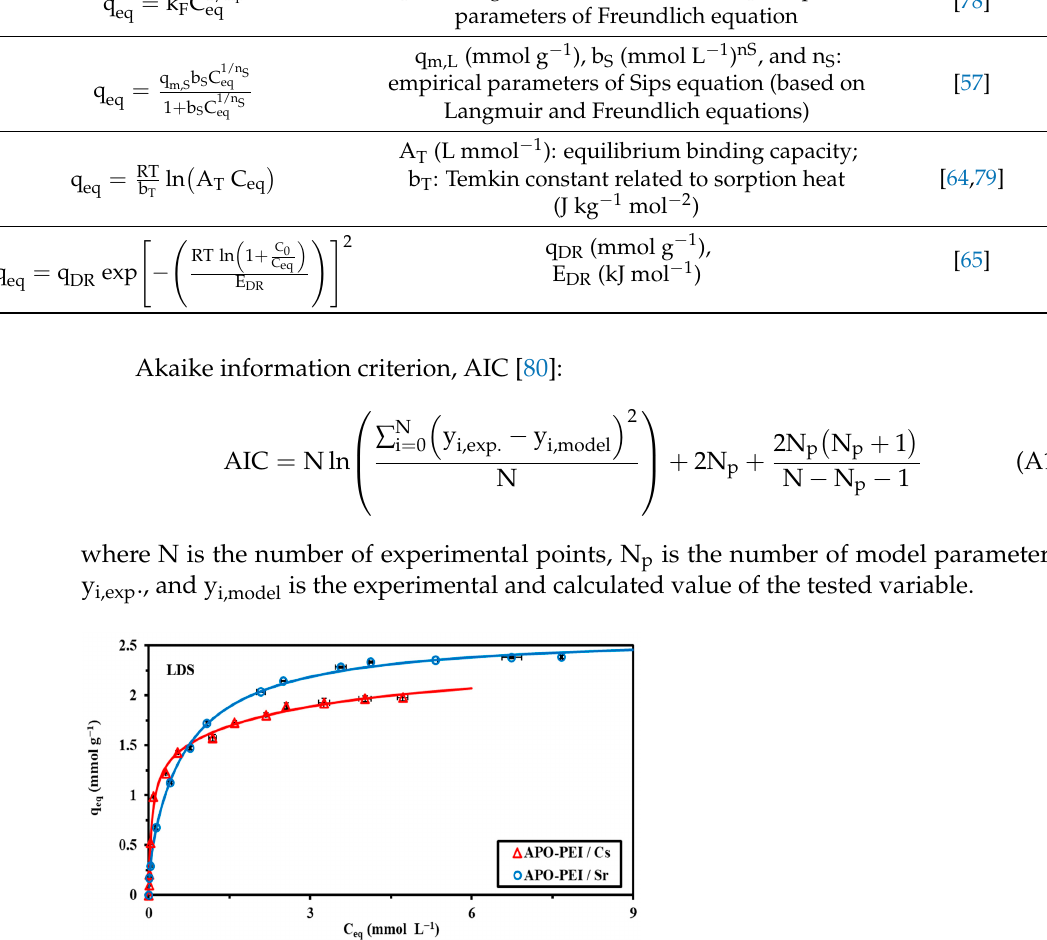
Figure A13. Sorption isotherms for Cs(I) ( a ) and Sr(II) ( b ) using ALG-PEI and APO-PEI sorbents: modeling with the Langmuir equation (pH 0 : 7; C 0 : 0.08–6.11 mmol Cs L − 1 or 0.12–9.32 mmol Sr L − 1 ; Table A3. Equations used for modeling sorption isotherms.